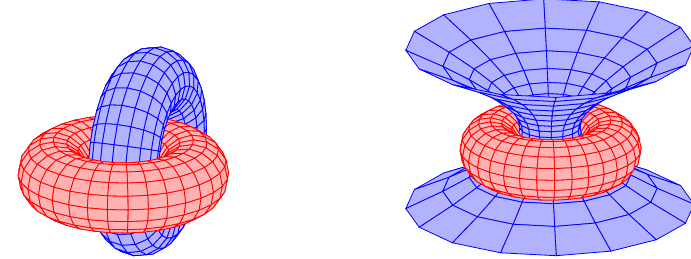
Figure 3 . S 3 can be also obtained by gluing two interlocked solid tori. The gluing is done by identifying the boundaries of them in a way that the cycles homologous to the a -cycle of one of the boundary torus are identi(cid:12)ed to the cycles homologous to the b -cycle of the other boundary torus. On the left we have depicted (cid:12)nite torii to illustrate the interlocking, while the right (cid:12)gure is more true to the spirit of the decomposition (with the point at in(cid:12)nity